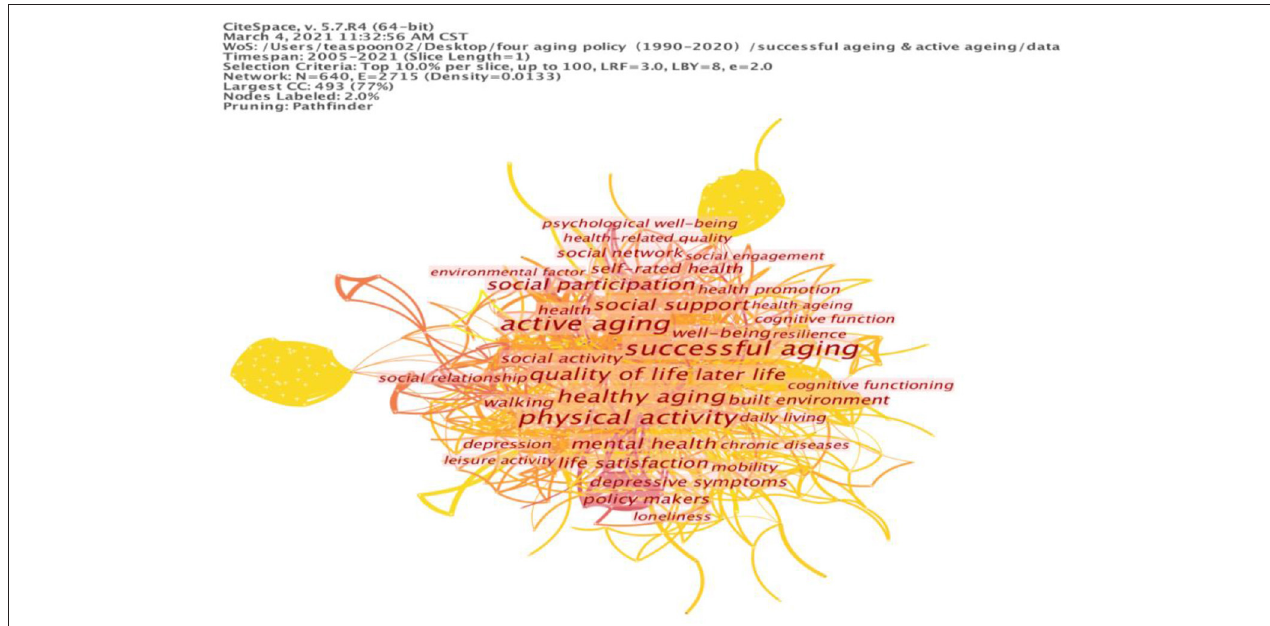
FIGURE 3 | Cluster map of keywords on successful aging and active aging.